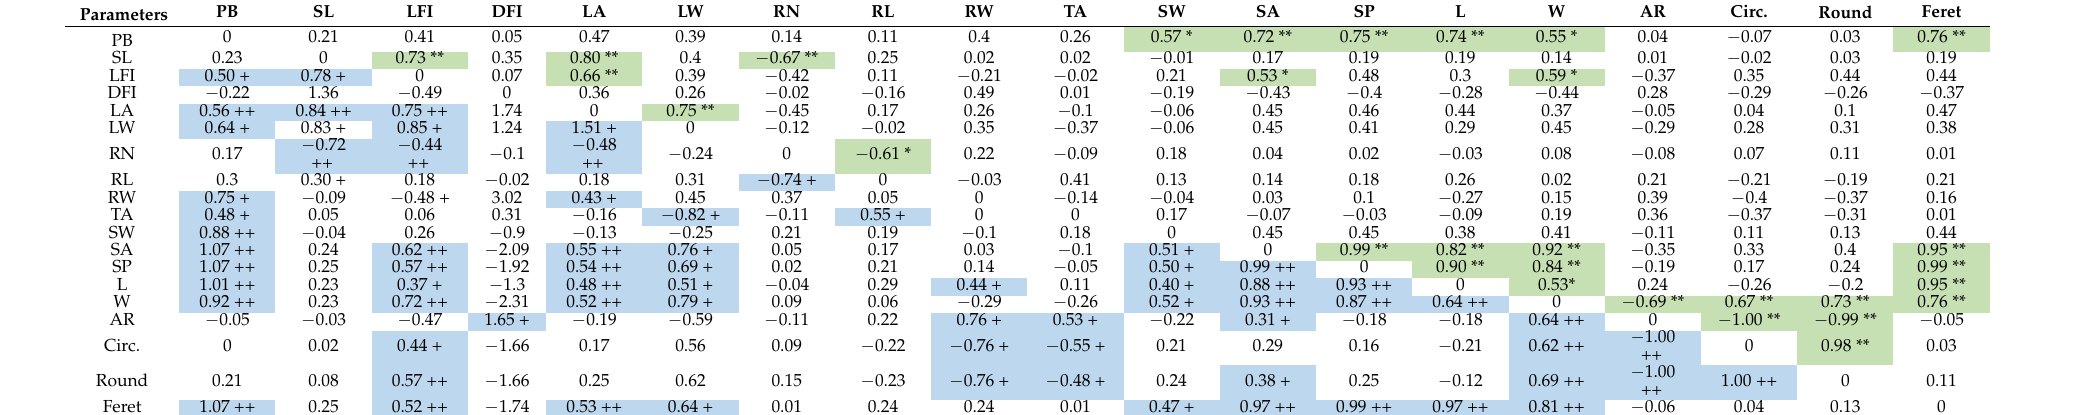
Table 5. Genotypic (r g ) (lower diagonal) and phenotypic (r p ) (above diagonal) correlation matrix among all morphological traits of the 16 T. aestivum genotypes